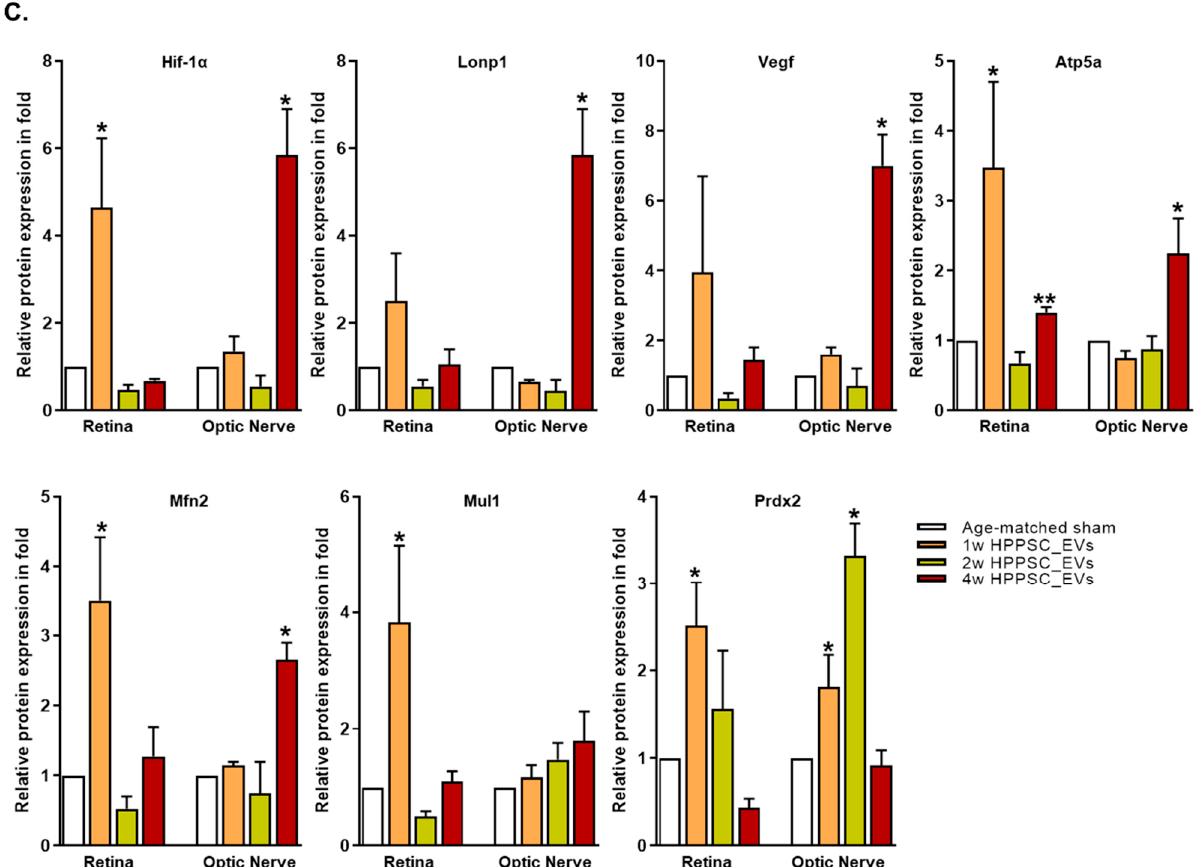
Figure 6. Effects of HPPSC_EVs on recovery and regeneration of RGCs in ONC models. ( A ) Representative confocal microscope ‐ based fluorescence images of Brn ‐ 3a and Tuj1 staining (original magnification: 400×) were presented in retinal tissues of optic compressed animal models injected with PSC_EVs and HPPSC_EVs. By immunoblot analysis, ( B ) regeneration related protein expressions were investigated in optic nerve tissues. And comparison of ( C ) mitochondrial function related protein expressions between retina and optic nerve tissues were performed. Total of two or three retinas and optic nerves from each group were used. The results are presented as a mean ± SEM. Significantly difference was estimated using an unpaired t test (* p < 0.05, ** p < 0.005, *** p < 0.0005, # p < 0.05, ## p < 0.01 vs. the age ‐ matched sham).